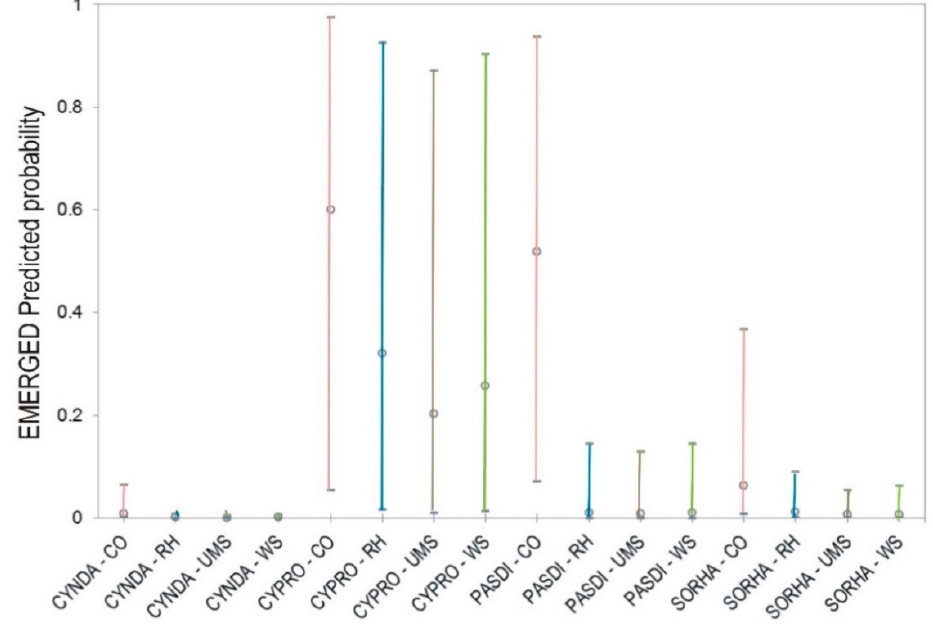
Figure 1. Least-squares means and their 95% confidence limits of the 16 combinations of the interaction effect ‘type of hydromulch × species’ for the variable EMERGED (proportion of rhizomes that produced emerged shoots) in which, analyzed by means of generalized linear mixed models, the interaction was significant at p < 0.05. CYNDA: Cynodon dactylon , CYPRO: Cyperus rotundus , PASDI: Paspalum dilatatum , SORHA: Sorghum halepense . CO: non-mulched control, RH: rice husk, UMS: used mushroom substrate, WS: wheat